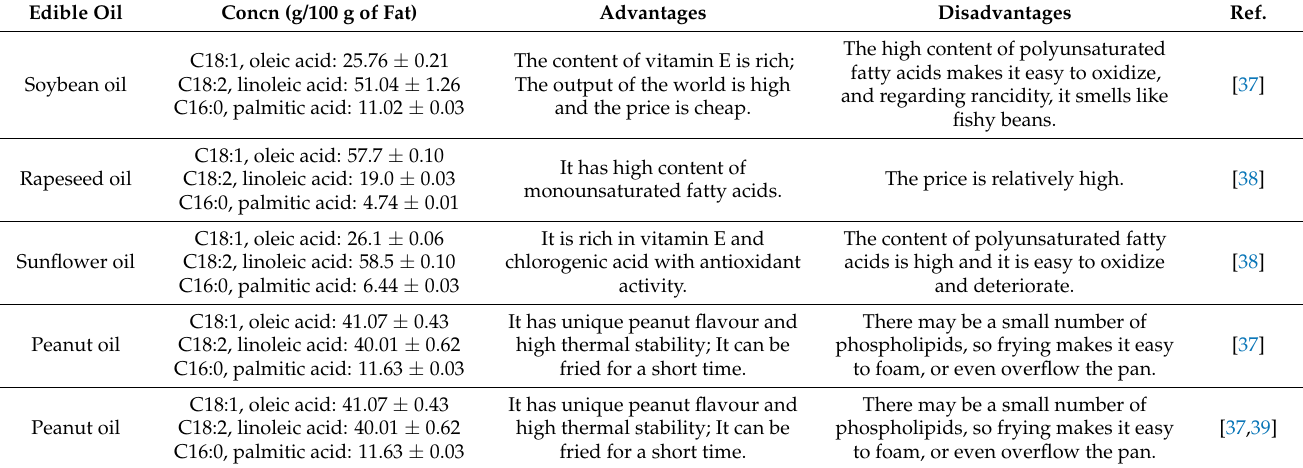
Table 1. Fatty acid composition, advantages and disadvantages of different edible oils.